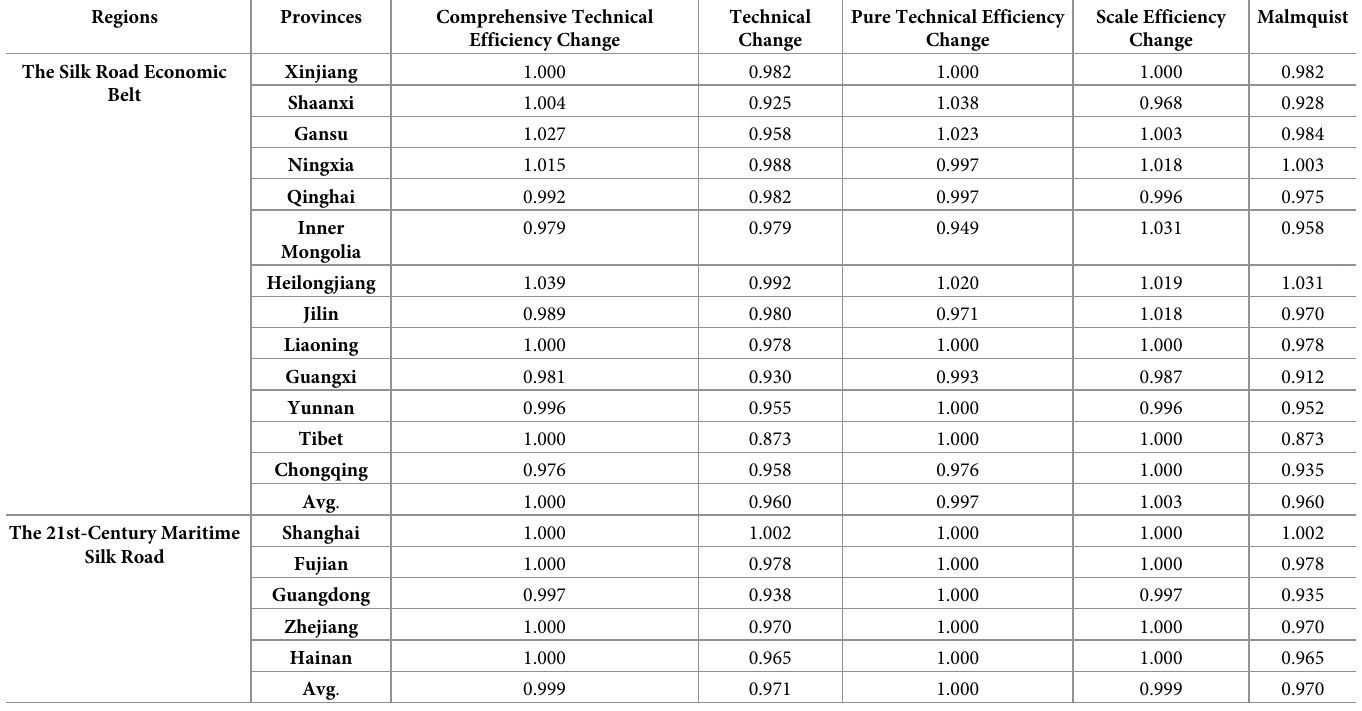
Table 8. Dynamic evolution of agricultural carbon emission efficiency of each province along the B&R, 2006–2015.